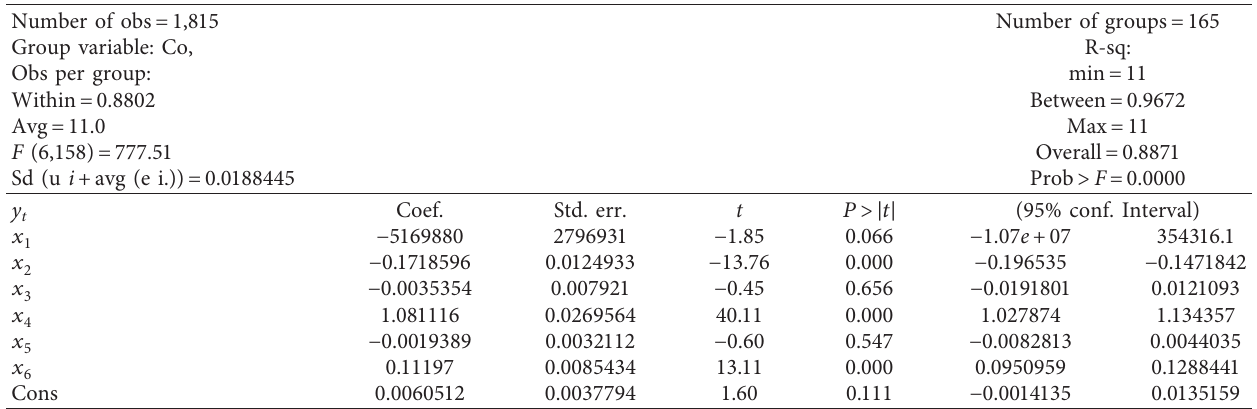
Table 5: The results of between-group